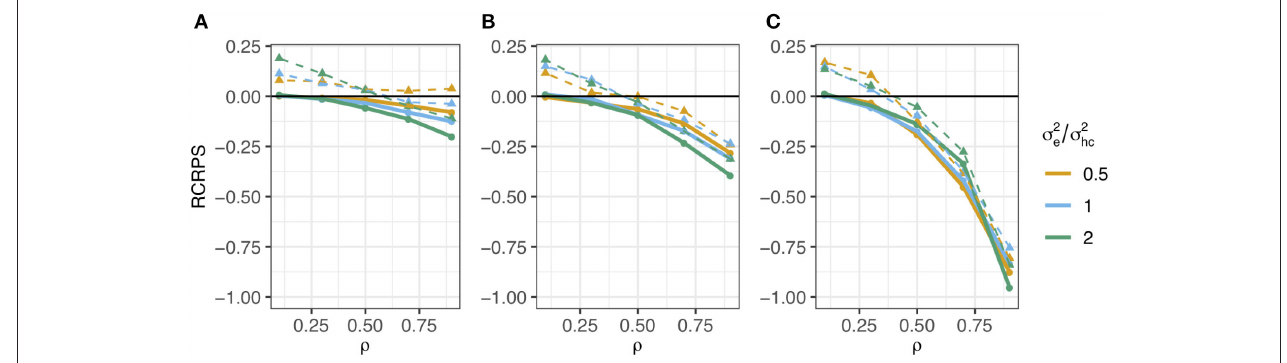
FIGURE 3 | RCRPS (smaller values indicate that the HN or mutation models, respectively, are better than the reference IH model) between the HN model and the IH model (solid line) and between the mutation model and the IH model (dashed line) for data simulated from the HN model with varying ρ parameter and ratio between the residual σ 2 e and conditional haplotype variance σ 2 h . The three panels show RCRPS for the haplotypes that were observed in (A) several phenotyped individuals, c (B) only one phenotyped individual, and (C) were not observed in a phenotyped individual.